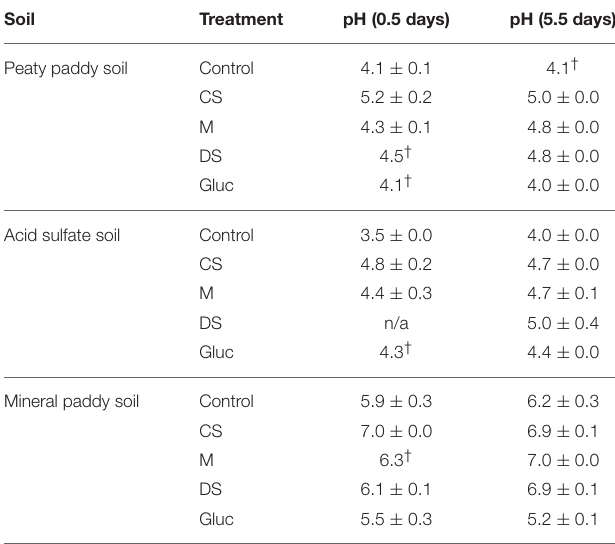
TABLE 4 | pH (average of duplicate vials ± standard deviation) in solution after 1.5 and 5.5 days of incubation, respectively. Soil